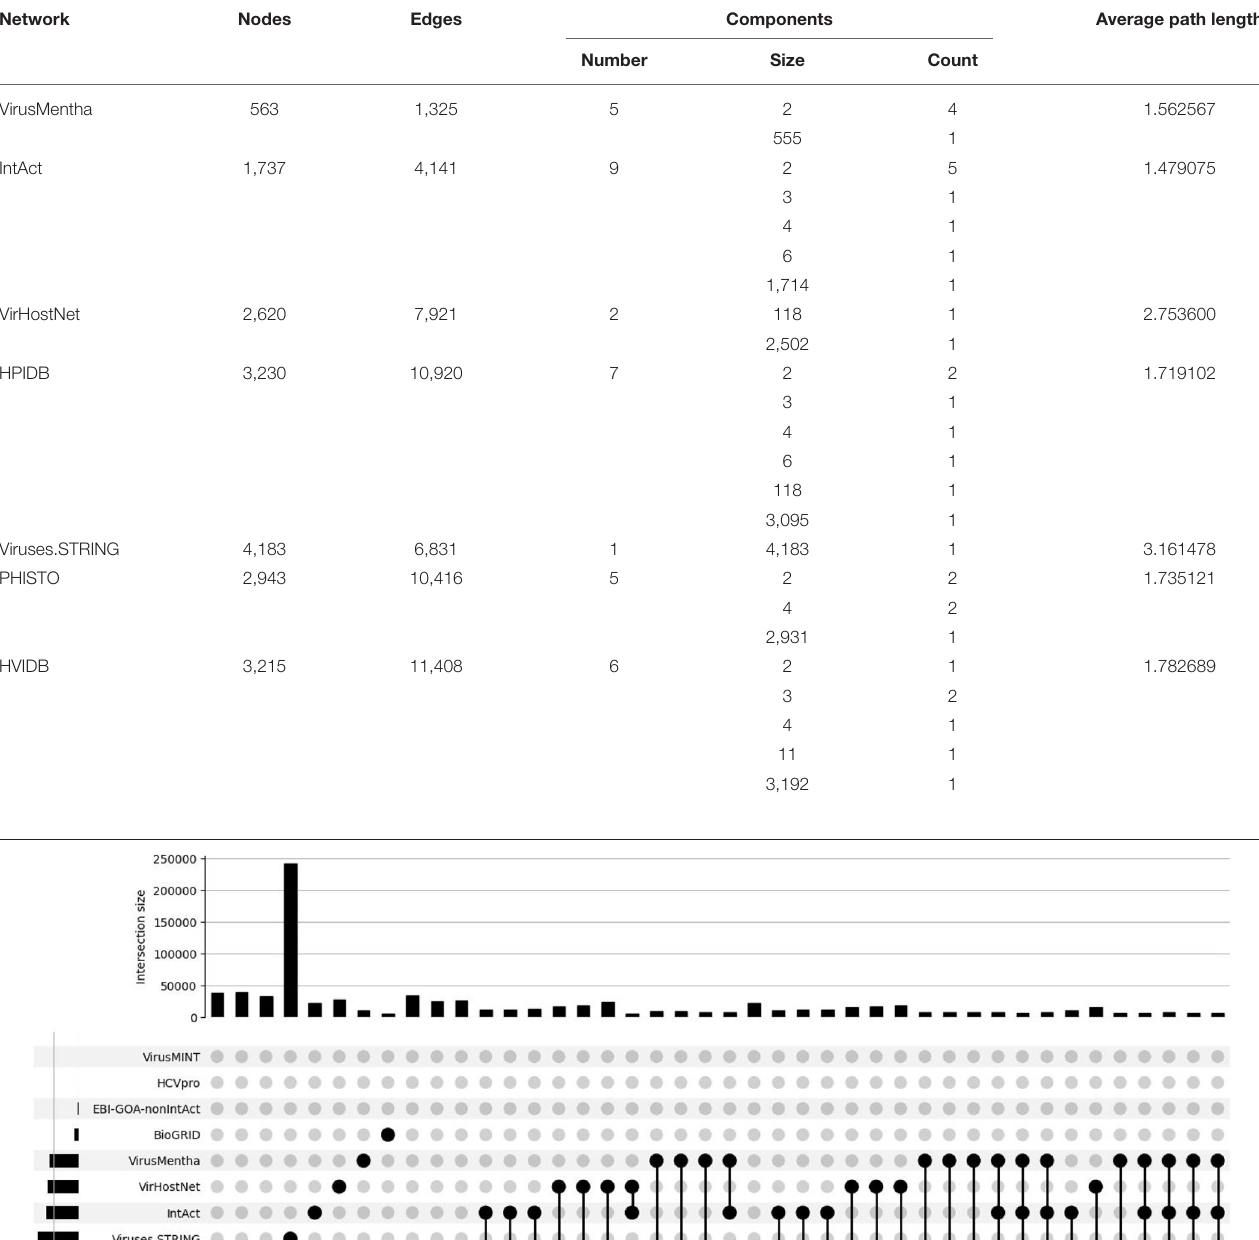
TABLE 4 | Structure of the Influenza A virus-host protein–protein interaction networks. Network Nodes Edges Components